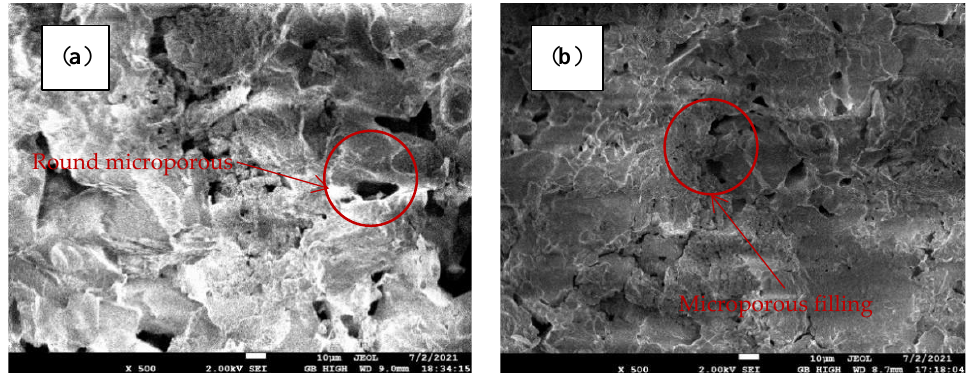
Figure 22. Comparison of SEM micromorphology of two kinds of sintered bricks. ( a ) MRB sintered brick. ( b ) MGB sintered brick.